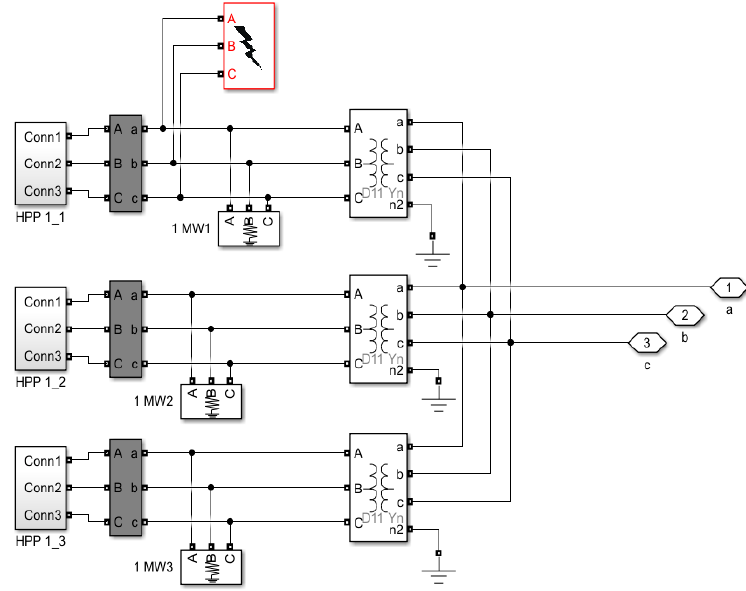
Figure 8. Three-phase short-circuit at the generator terminals.